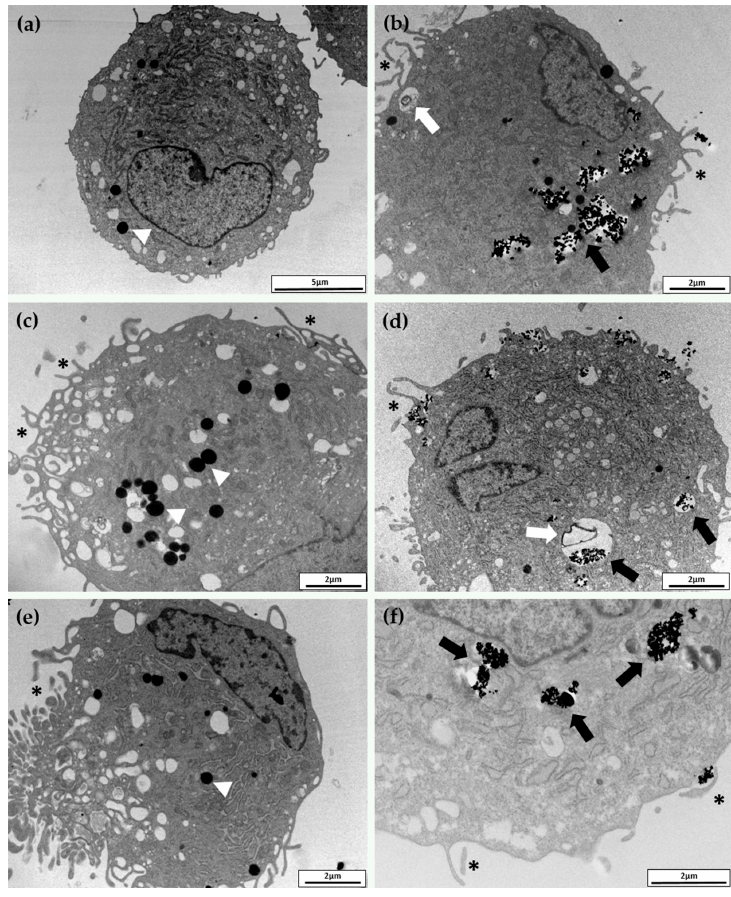
Figure 4. Transmission electron microscopy images of typical hASCs exposed for 24 h to FeMPs ( a ), FeNPs ( b ), CoMPs ( c ), CoNPs ( d ), NiMPs ( e ), and NiNPs ( f ). NPs were identified as high-electron-density objects when inside the cell and localized inside the vesicles (black arrows). No differences were observed among the three considered NPs and the internalization appeared to be nonspecific. White arrows indicate lysosomes of different sizes containing amorphous material. Several pronounced pseudopodia-like protrusions (*) are present both in NP- and in MP-exposed cells. Nuclei and mitochondria do not contain NPs. Arrowheads indicate lipid droplets.